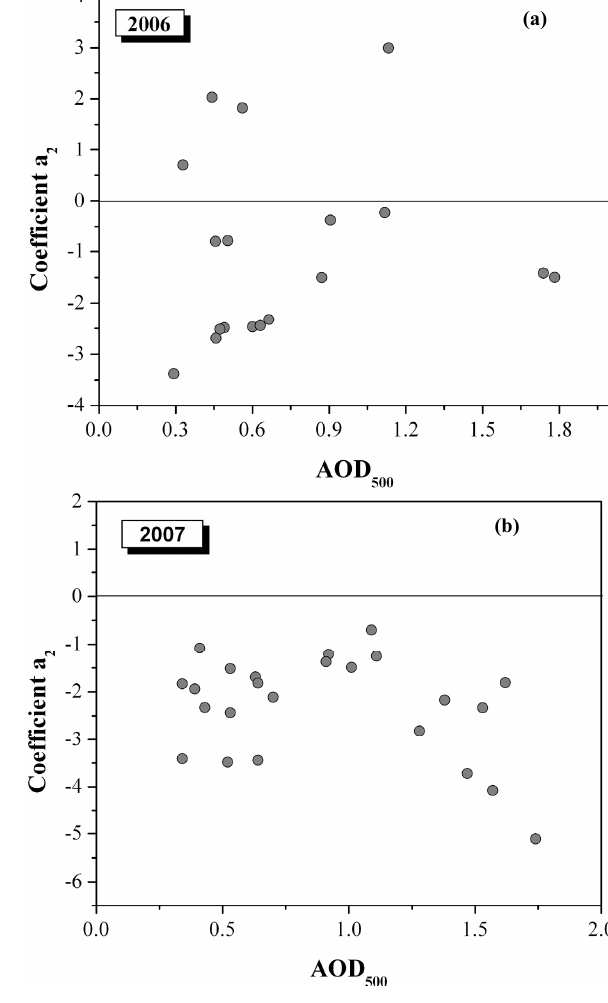
Fig. 5. Scatter plot of coefficient a 2 against AOD 500 during (a) Oc- tober 2006 and (b) October